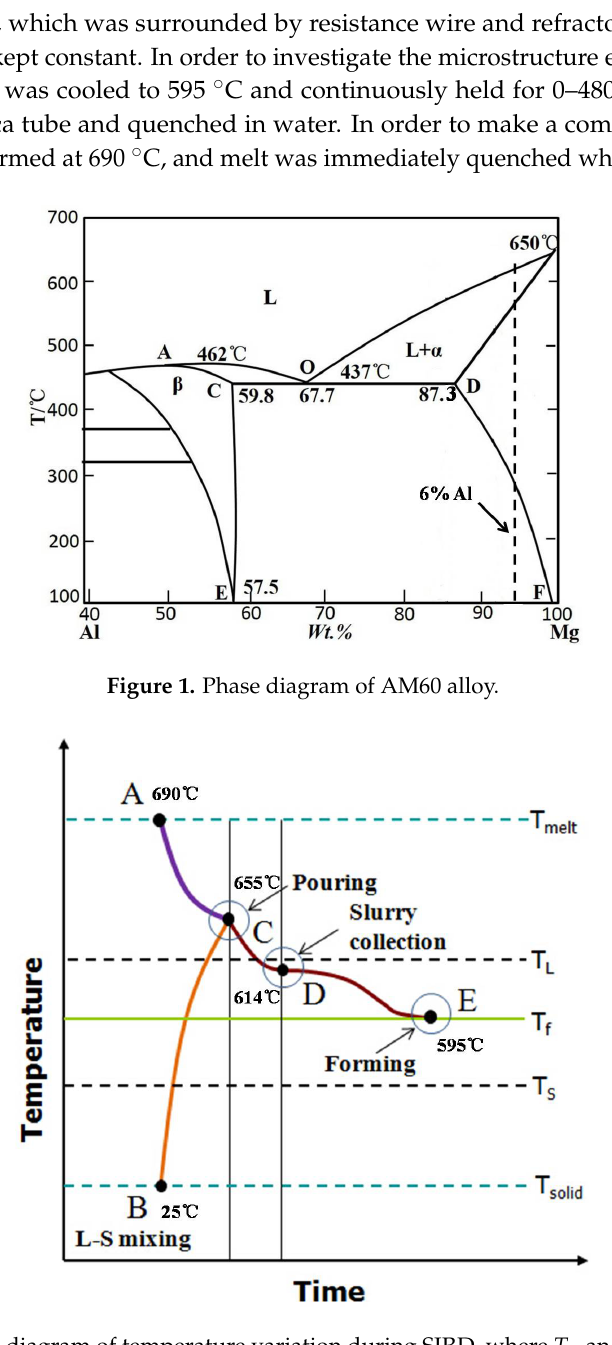
Figure 2. Schematic diagram of temperature variation during SIRD, where T L and T S is the liquidus and solidus temperature of AM60 alloy, respectively.